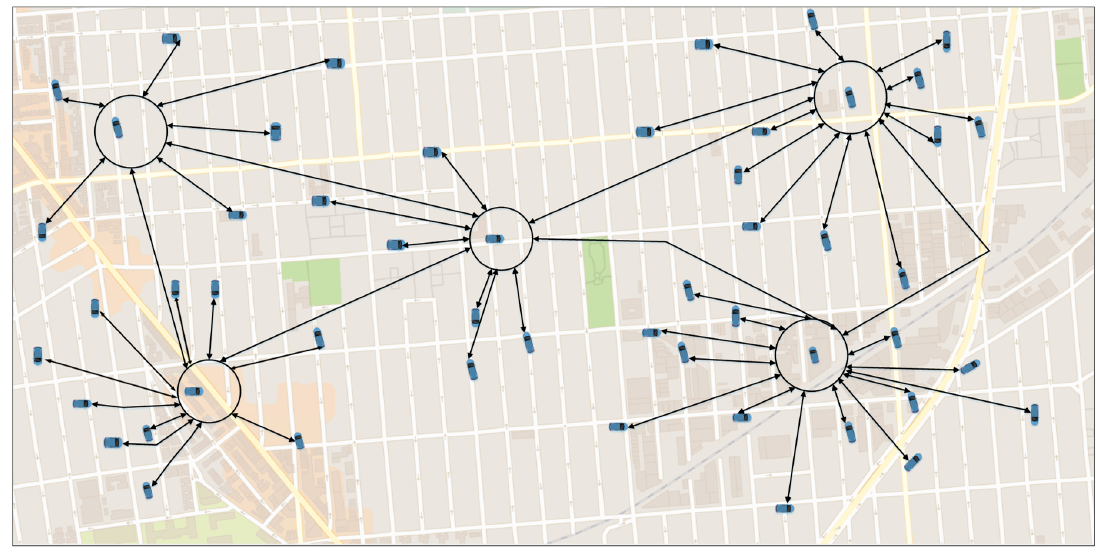
Figure 1. Clients-VVS communications.